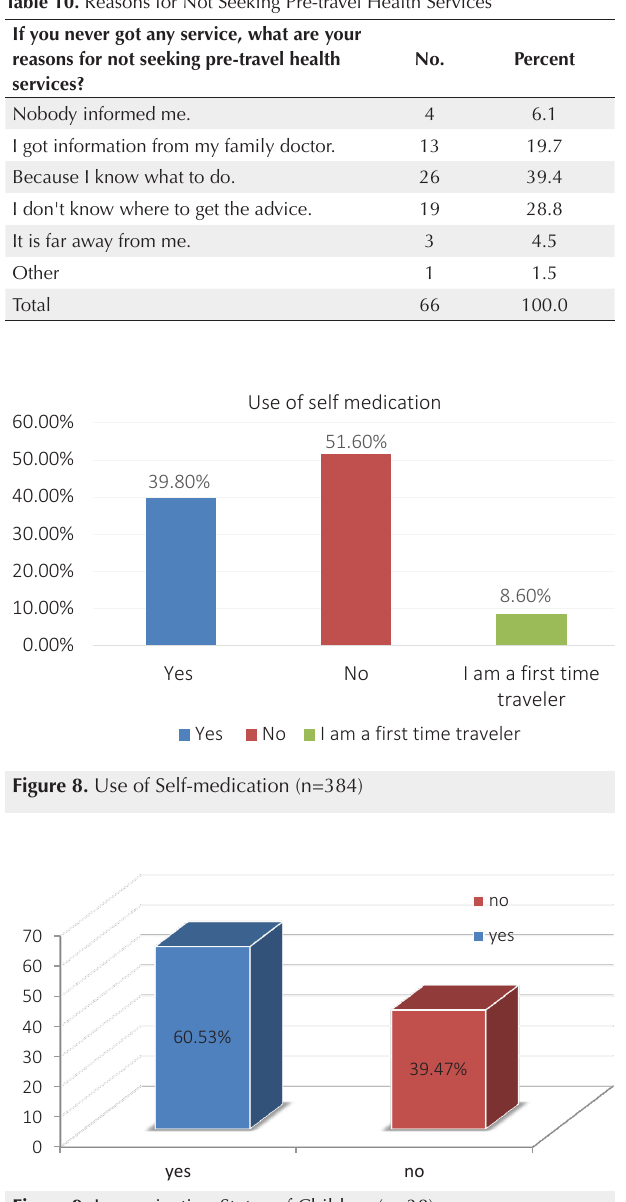
Figure 9. Immunization Status of Children (n=38)